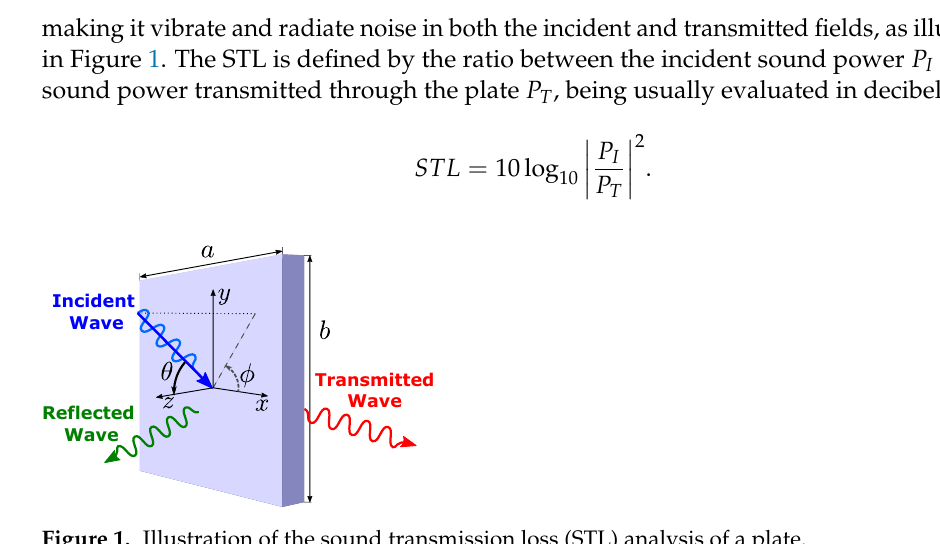
Figure 1. Illustration of the sound transmission loss (STL) analysis of a